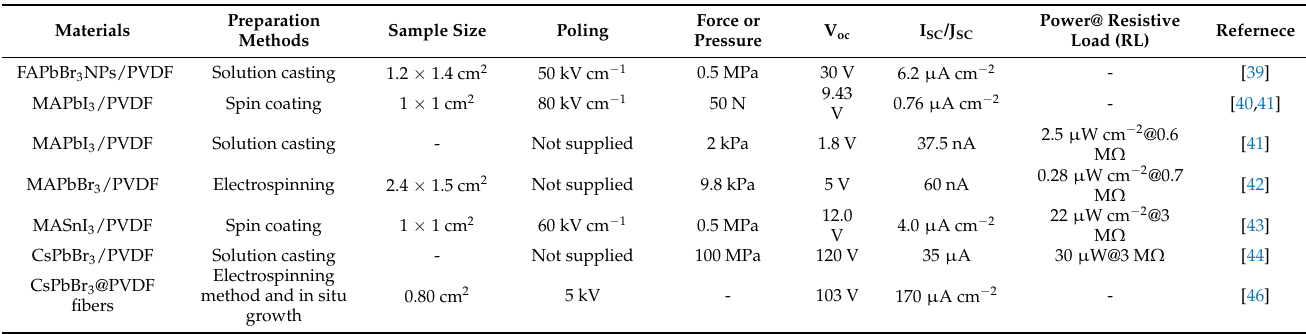
Figure 4. Side views of the PVDF chain ( a ) and the rhombic CsPbBr 3 ( b ). ( c ) Top view of the CsPbBr 3 –PVDF composite [44]. Reproduced with the permission from reference [44]. Table 1. Performance of several poly(vinylidene fluoride) (PVDF)–based metal halide perovskite piezoelectric nanogenerator s (PENG s ).